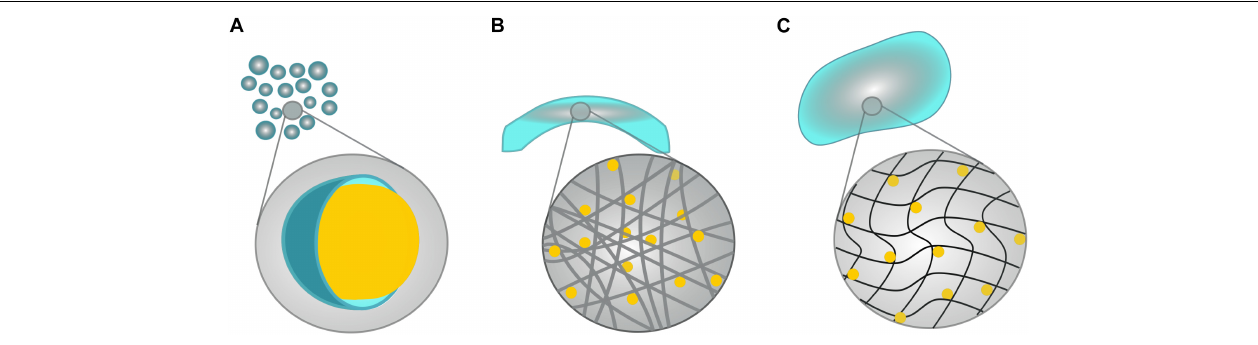
FIGURE 2 | Schematic of possible biomaterial scaffolds. Although hundreds of biomaterials have been generated, they fall neatly into four main categories: (A) Microspheres are small, polymeric spheres (shown in blue) that encapsulate a target drug or molecule (as depicted by the yellow sphere). (B) Electrospun fibers consist of long, usually cylindrical, and fibers that are commonly crafted into tubes or conduits. Target drugs can either be bound to the fibers themselves, or left to freely diffuse from the fiber network. (C) Hydrogels consist of hydrophilic, polymeric networks that swell to conform to cavities formed by neurodegenerative diseases/injuries, and facilitate the passive release of target